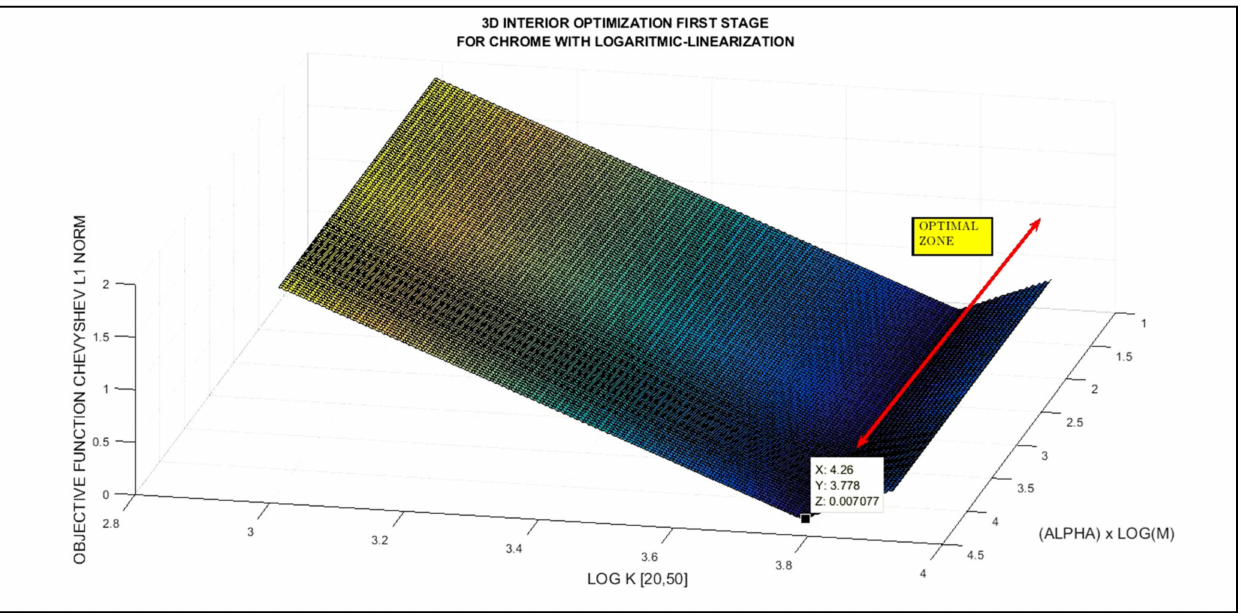
Figure 5. Another perspective of chrome first stage of 3D interior optimization. Optimal zone is accurate and residual is about 7 × 10 − 3 . This value validates the chrome GA results. Image processing method